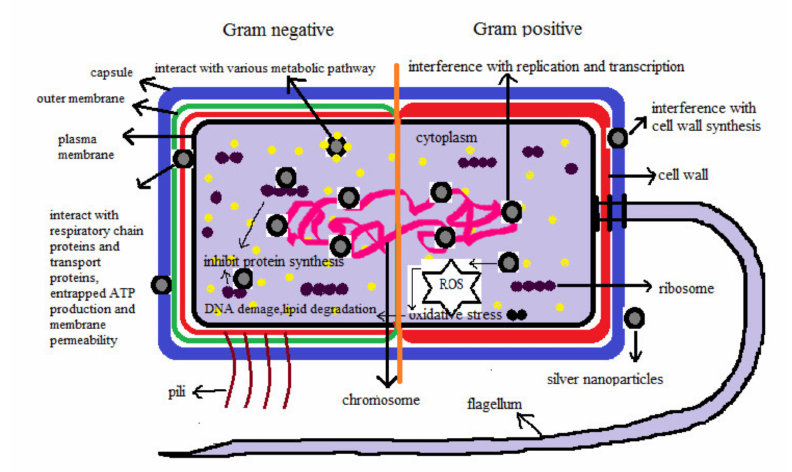
Figure 4. Antibacterial mechanism of AgNPs